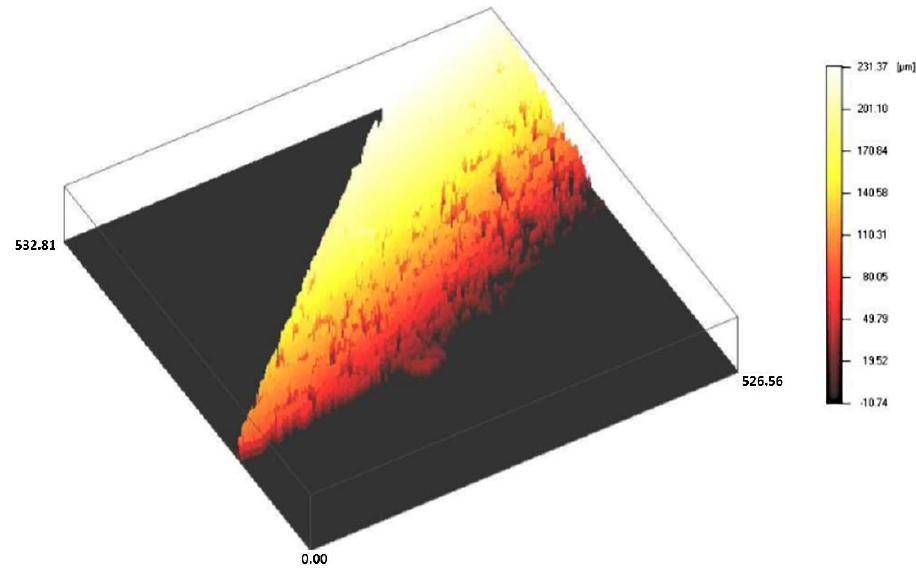
Figure B1. High-resolution nano-focus image. Figure A5. High-resolution nano-focus